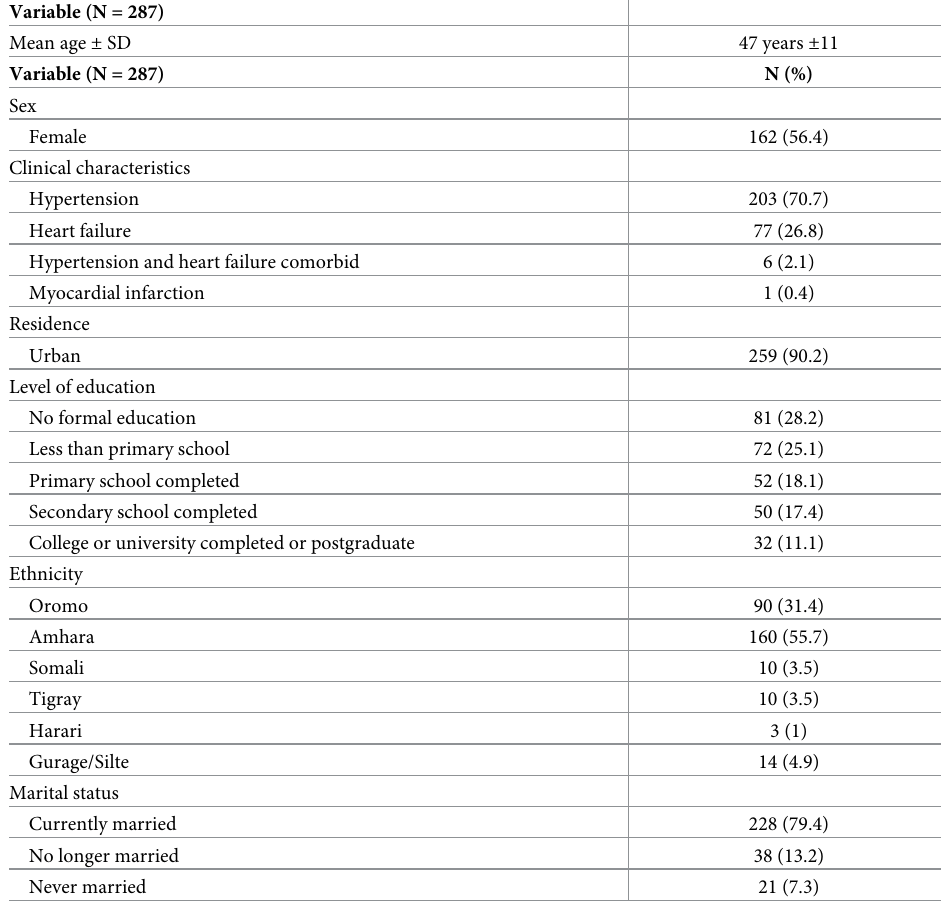
Table 1. Sociodemographic characteristics of patients attending chronic follow up care in eastern Ethiopia,